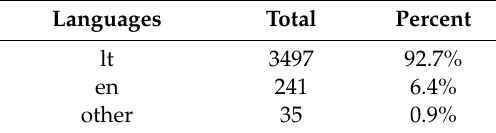
Table A33. Primary languages (lt).